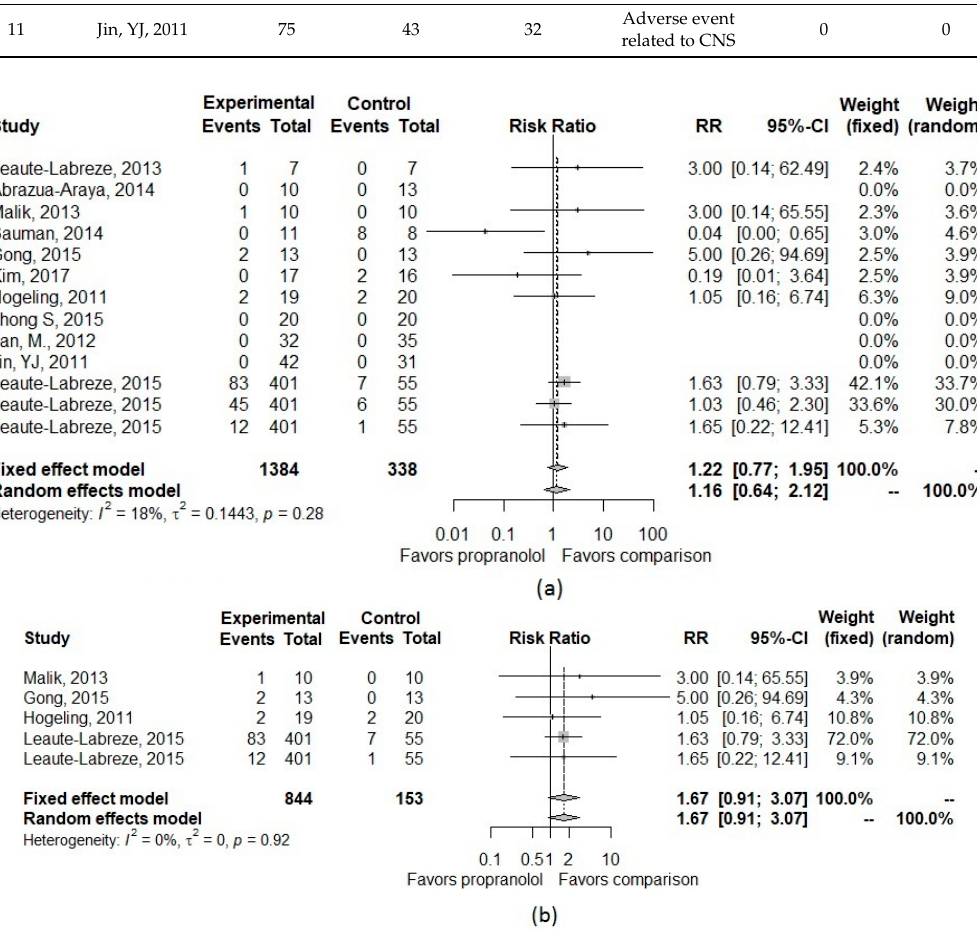
Figure 3. Forest plot of the pooled risk ratio of ( a ) all CNS effects and ( b ) only sleep-related effects in the main analysis.